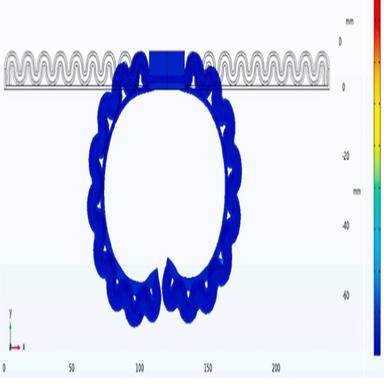
FEA - bending-close behavior under a pressure of 24 psi. Von Mises Stress .